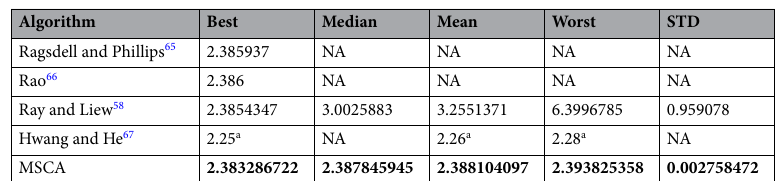
Table 16. Statistical result for welded beam design problem on version I. NA means not available; a means infeasible. Significant values are in bold.